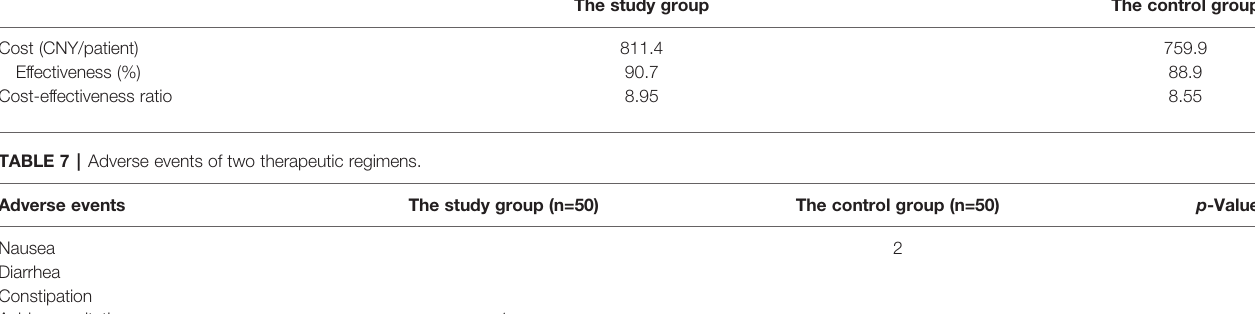
TABLE 6 | The cost-effectiveness analysis of the two therapeutic regimens.